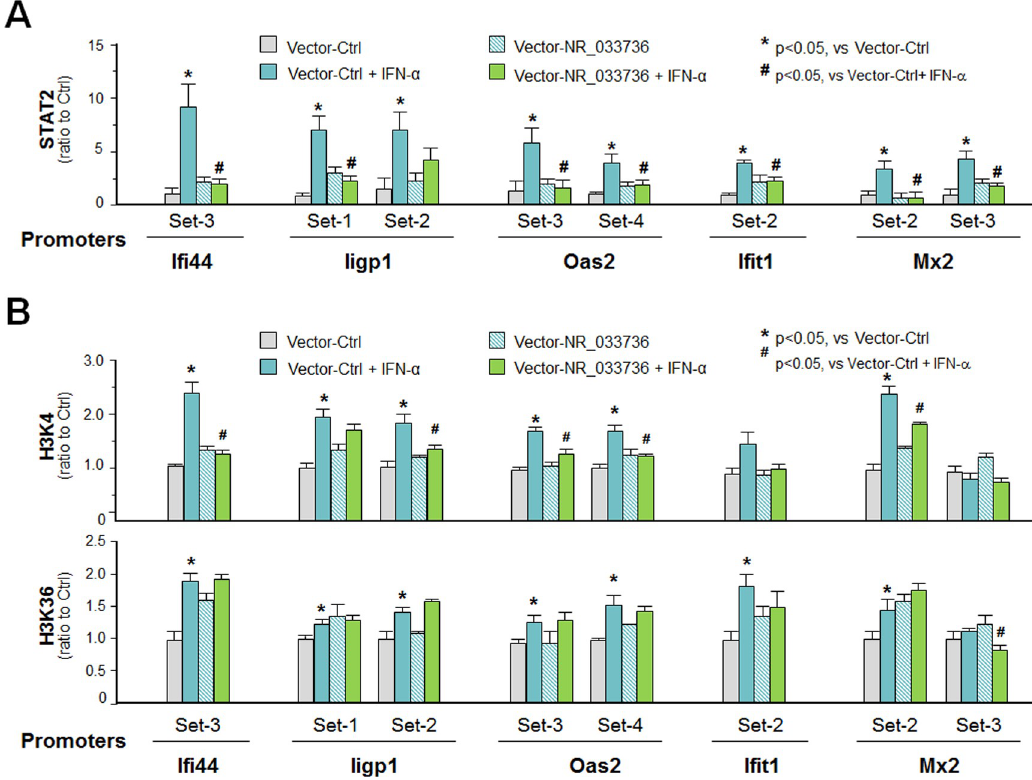
Fig 6. Impact of NR_033736 expression on the recruitment of STAT2 and enrichment of transcriptional active histone modifications at the promoter regions of type I IFN-controlled genes in IEC4.1 cells in response to Ifn- α stimulation. (A) Impact of NR_033736 expression on recruitment of STAT2 to the promoter regions of type I IFN-controlled genes in IEC4.1 cells in response to Ifn- α stimulation. Cells were transfected with the vector expression NR_033736 (Vector-NR_033736) or the empty vector (Vector-Ctrl) for 24 h and then exposed to Ifn- α stimulation for 2 h. Recruitment of STAT2 was measured using the ChIP assay with anti-STAT2 and PCR primers covering the known regions of the gene loci. (B) Impact of NR_033736 expression on enrichment of transcriptional active H3K4 and H3K36 methylations to the promoter regions of type I IFN-controlled genes in IEC4.1 cells in response to IFN- α stimulation. Cells were transfected with the Vector-NR_033736 or Vector-Ctrl for 24 h and then exposed to IFN- α stimulation for 2 h. Enrichment of H3K4 and H3K36 was measured using the ChIP assay with anti-H3K6 and H3K36, respectively, and PCR primers covering the known regions of the gene loci. Data represent three independent